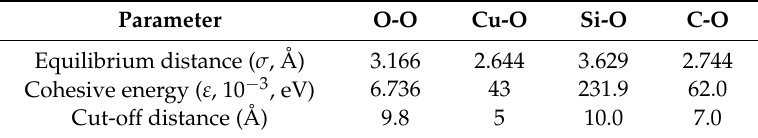
Table 1. LJ potential parameters for O-O, Cu-O, Si-O, and C-O atom pairs.